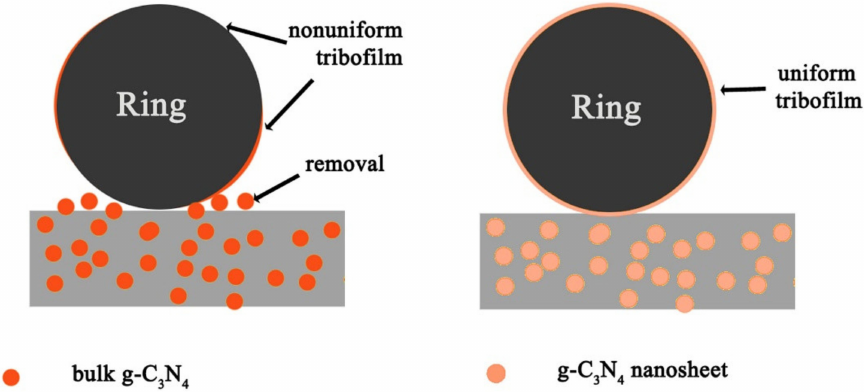
Figure 12. Wear mechanism experienced by g-C 3 N 4 -reinfroced phenolic coating (Reproduced with permission from L. Wu, Z. Zhang, M. Yang, J. Yuan, P. Li, F. Guo, X. Men, Tribology International; published by Elsevier, 2019)